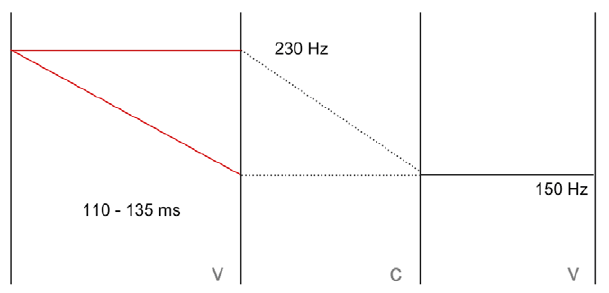
Figure 5. Schematic representation of the construction of materials in Experiment 2.